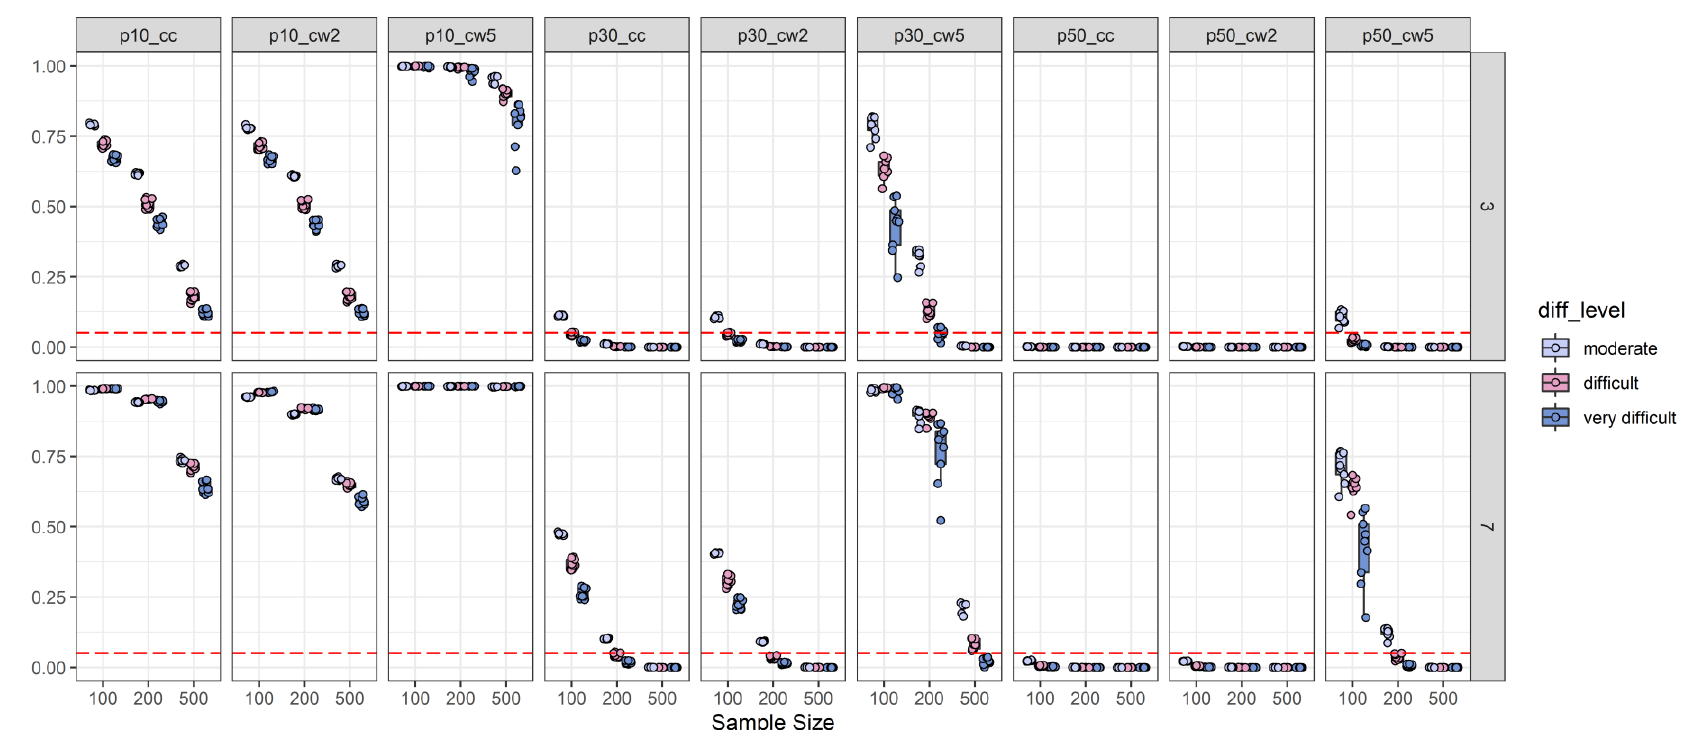
Figure 2. 2PL-difficulty split of type-I-error analysis: Depiction of the type-I-error rate (y-axis) as a function of sample size (x-axis), number of distractors (three distractors = top-row; seven distractors = bottom-row), 2PL-difficulty (diff_level: Moderate vs. difficult vs. very difficult), and effect size measures combined with effect size thresholds (see explanation) (p10_cc = canonical correlation with a 0.10 threshold; p10_cw2 = Cohen’s ω based on two ability groups with a 0.10 threshold; p10_cw5 = Cohen’s ω based on five ability groups with a 0.10 threshold; p30_cc = canonical correlation with a 0.30 threshold; p30_cw2 = Cohen’s ω based on two ability groups with a 0.30 threshold; p30_cw5 = Cohen’s ω based on five ability groups with a 0.30 threshold; p50_cc = canonical correlation with a 0.50 threshold; p50_cw2 = Cohen’s ω based on two ability groups with a 0.50 threshold; p50_cw5 = Cohen’s ω based on five ability groups with a 0.50 threshold). The horizontal red dashed line represents the target type-I-error rate of 0.05.